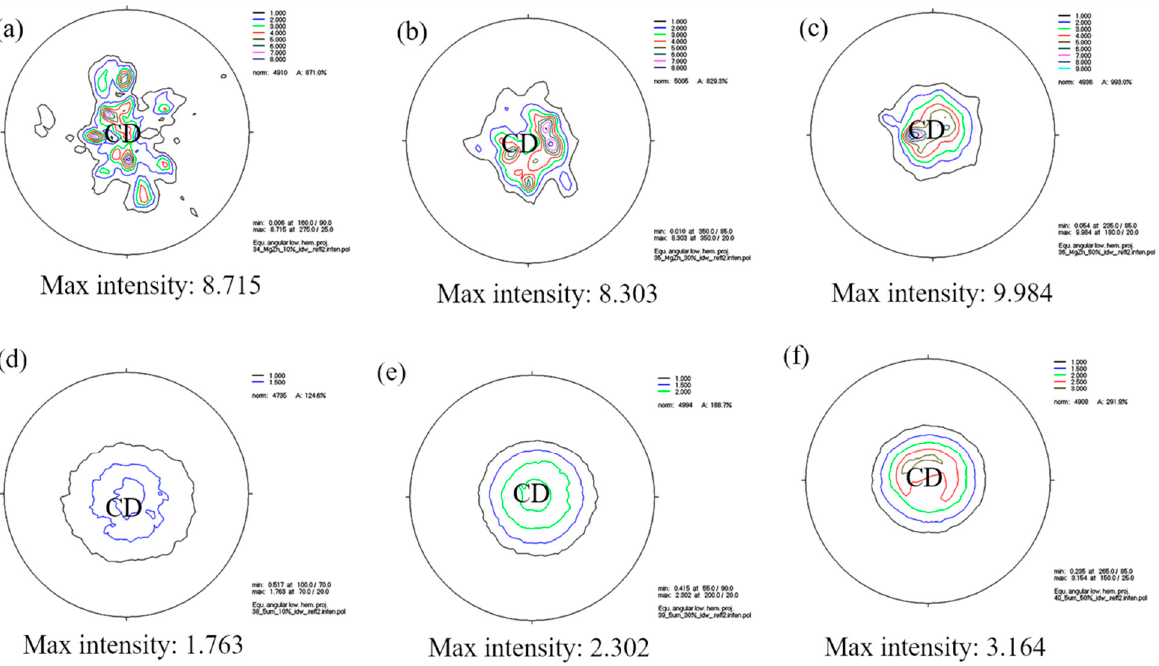
Figure 16. Macro-texture distribution of (0002) basal plane of ( a – c ) Mg-5Zn alloy and ( d – f ) SiC p /Mg- 5Zn material with different compression strains: ( a , d ) 0.1, ( b , e ) 0.35 and ( c , f ) 0.7.